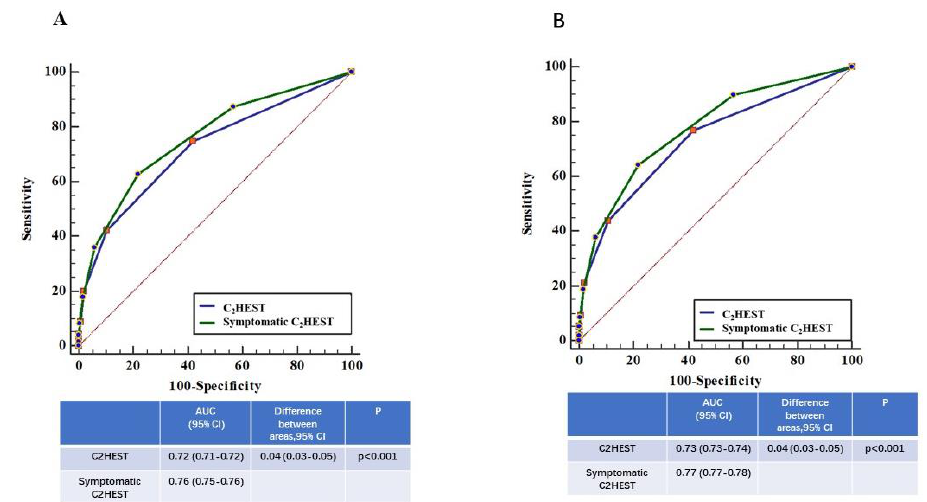
Figure 2. Comparison of ROC curves of C 2 HEST and symptomatic C 2 HEST. ( A ) Suspected AF, ( B ) Confirmed AF. * Symptomatic C 2 HEST: C 2 HEST plus palpitation. AUC, areas under the curve. CI, confidential interval.